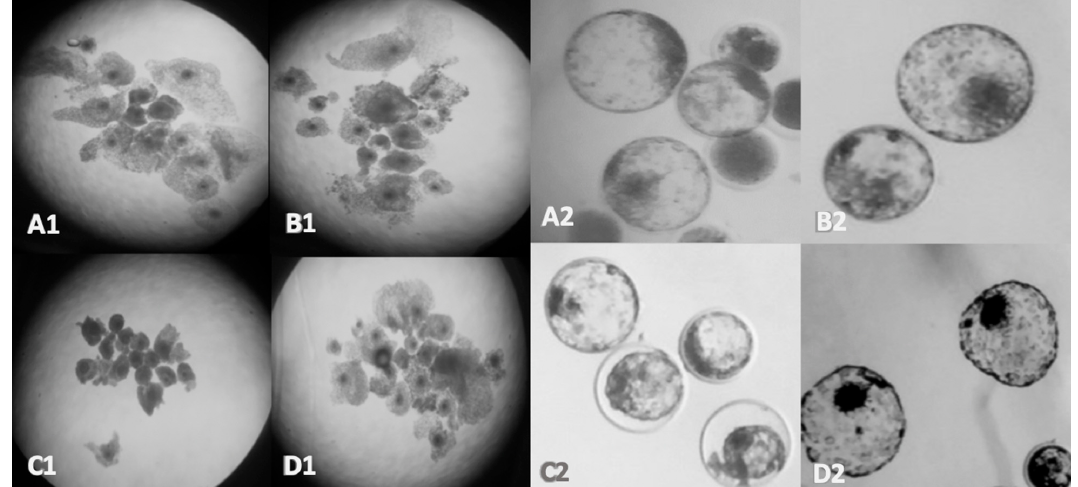
Figure 1. Morphological features of Bos Taurus COCs and embryos. Oocyte maturation after 24 hrs ( left ) and day 8 embryo development ( right ); ( A ): Control, ( B ): Vehicle (0.1% ethanol), ( C ): BPA (0.05 mg/mL), ( D ): BPS (0.05 mg/mL) imaged using a 10 × objective for the oocytes and at 40 × objective for the blastocysts.